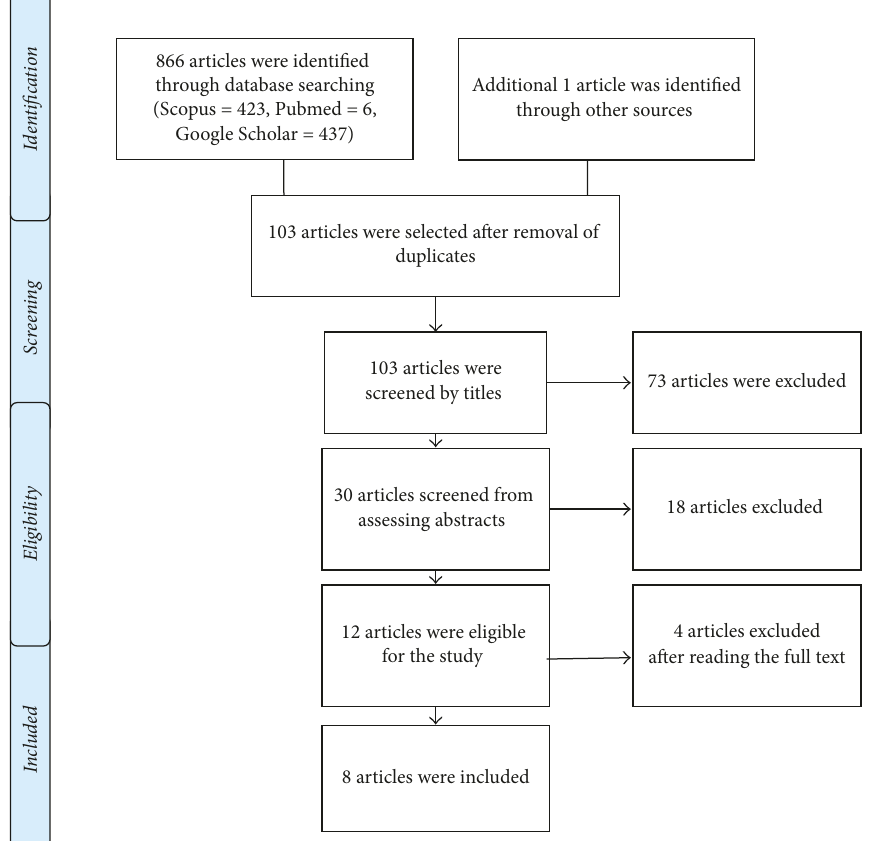
Figure 1: Schematic diagram representing the search